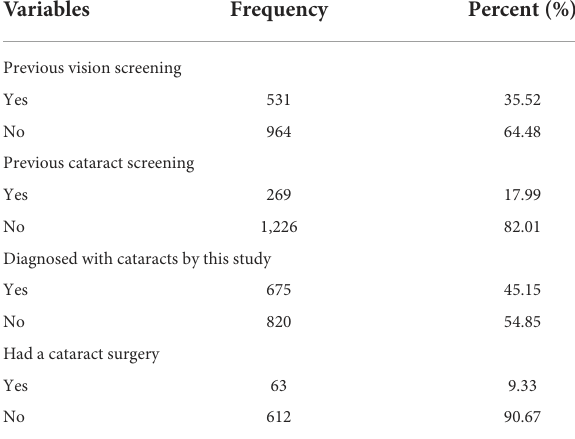
TABLE 1 Sociodemographic characteristics of adults aged 50 and above in rural Western China ( n = 1,495).